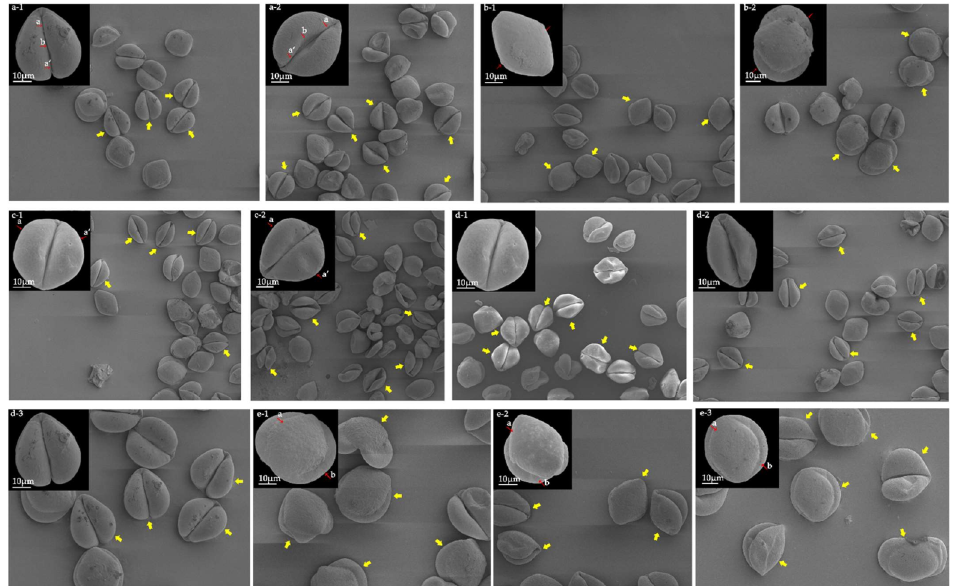
Figure 3. Description for five new qualitative traits of pollen, the yellow arrow indicate typical pollen grains. Anacolpus was uniform or not in the polar distal view (B-GU): ( a-1 ) Anacolpus was uniform in the polar distal view given the subequal values among a, b, and a’ (Yes, 1). ( a-2 ) Anacolpus was nonuniform in the polar distal view as the b was wider than a or a’ (No, 0). Whether the outline of two sacci was distinct or not in the polar proximal view (B-SD): ( b-1 ) The outline of two sacci was not distinct in the polar proximal view (Haploxylon-type) (No, 0). ( b-2 ) The outline of two sacci was distinct in the polar proximal view (Diploxylon-type) (Yes, 1). Whether the overall size of two sacci was uniform or not (B-SU): ( c-1 ) The overall size of two sacci (a and a’) was uniform (Yes, 1). ( c-2 ) The overall size of two sacci was nonuniform because the saccus was larger for a’ than a (No, 0). The pollen corpus outlined in the polar distal view (O-CO): ( d-1 ) Suborbicular (suborbicular, 1). ( d-2 ) Ellipse (ellipse, 2). ( d-3 ) Subcordate (subcordate, 3). Roughness degree between the corpus from the polar proximal view and the sacci from the polar distal view (O-CSR): ( e-1 ) The corpus is rougher than sacci in the polar distal view (much rougher in pollen corpus, 3). ( e-2 ) The corpus and sacci are not rough (all not rough, 1). ( e-3 ) The corpus and sacci are all rough as evinced by the many verrucae on the surface (all rough,